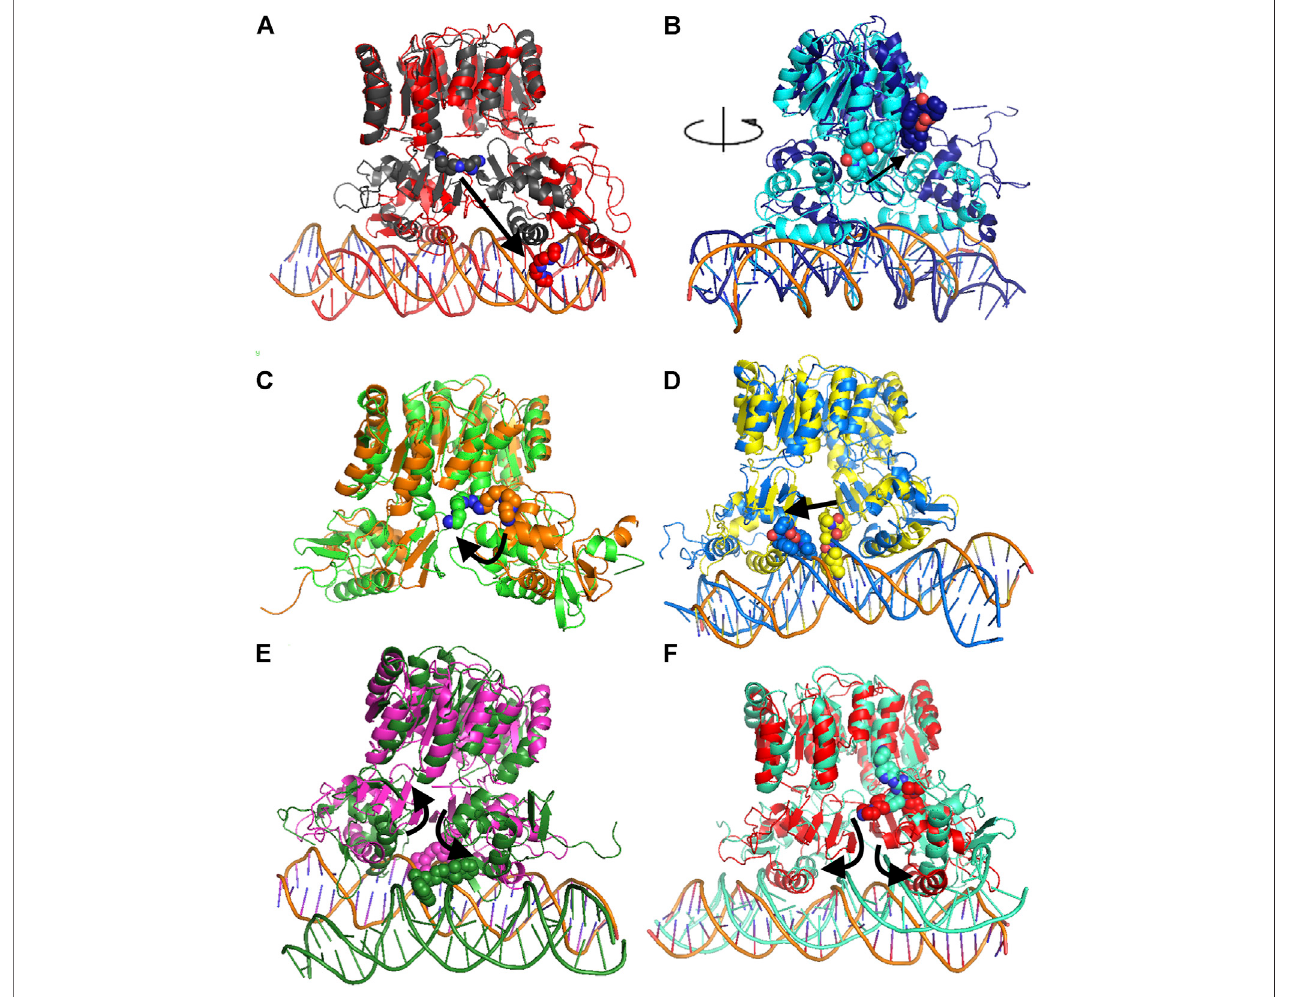
FIGURE4| ComparisonofMDrepresentativeconformationanddockingpose.HP1043_DNA – tetraethylenepentamine (A) ,HP1043_DNA – dihydroergotoxine (B) , HP1043 – tetraethylenepentamine (C) , HP1043_DNA – ergotamine (D) , HP1043_DNA – hexa fl uronium (E) , and HP1043_DNA – ribociclib (F) . Ligand and domain movementsareevidencedbyblackarrows.Dockingconformationareingray,lightblue,orange, yellow,pink, andlightred;representative MDconformationarecolored as DNA in red, dark blue, green, blue, dark green, and aquamarine.